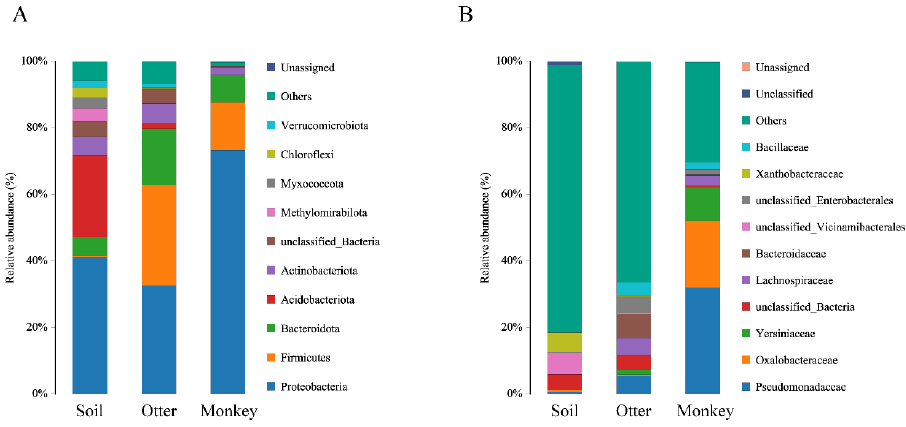
Figure 3. Composition of the microbial community at the genus level between groups ( A ) and individual samples ( B ).